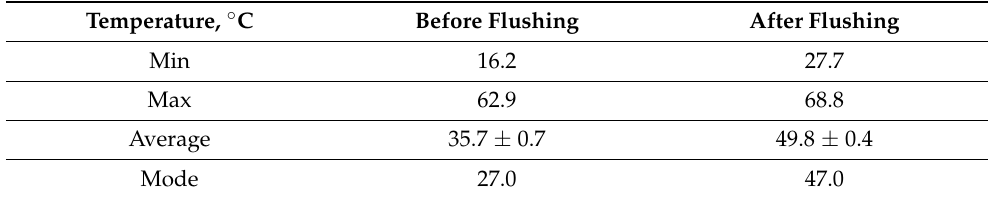
Table 3. The hot water temperature before and after flushing.